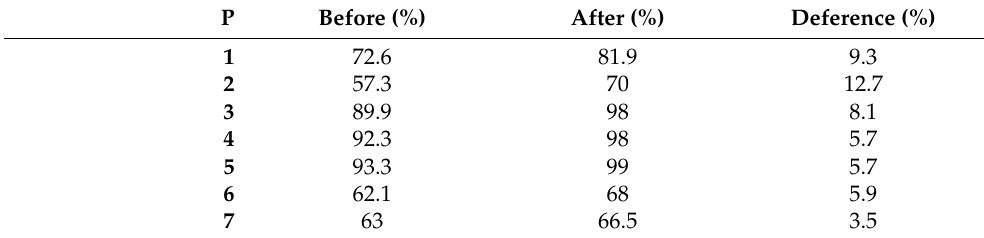
Table 4. GMFM total scores for before and after intervention